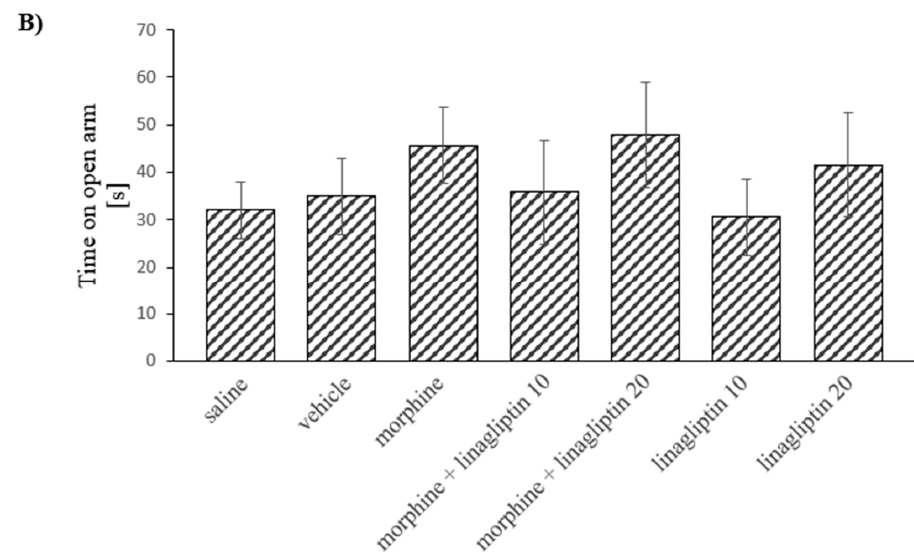
Figure 6. The influence of linagliptin (10 and 20 mg/kg, ip) administered during morphine withdrawal on the anxiety behavior observed in mice, in the elevated plus maze test, after: ( A ) short-term (60 h) and ( B ) long-term (14 days) morphine withdrawal. Morphine was administered twice a day for eight consecutive days (10, 15, 20, 25, 30, 35, 40 and 50 mg/kg, ip). Linagliptin was injected once a day in the morning during morphine withdrawal (altogether, 2 or 14 injections, respectively). The effect on anxiety was observed 60 h or 14 days after the last morphine injection (short-term or long-term withdrawal of morphine, respectively). The anxiety in mice was observed as the time that the mice spent in the open arm in the elevated plus maze test. The results are shown as the average time spent in the open arm (s) ± SEM. * p < 0.05 vs. saline/vehicle group, # p < 0.05 vs. morphine group, ## p < 0.01 vs. morphine group (the Tukey’s test).